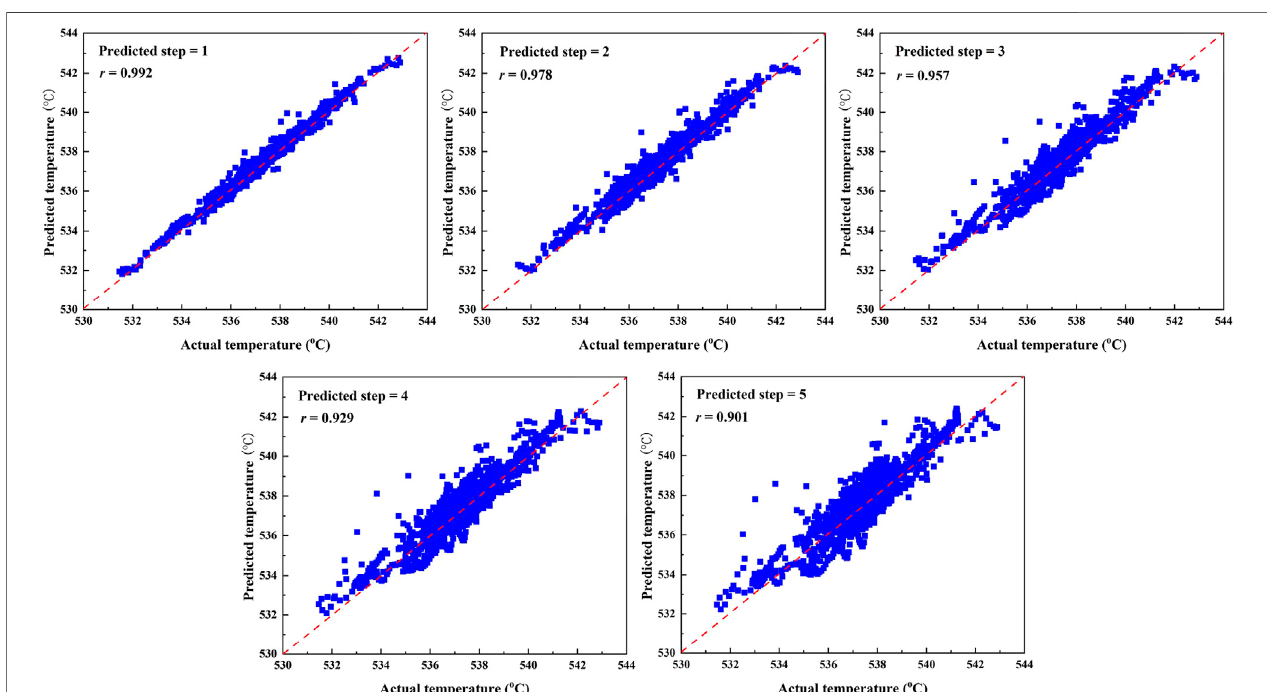
FIGURE 7 | Results of predicted temperatures versus measured temperatures from test data.